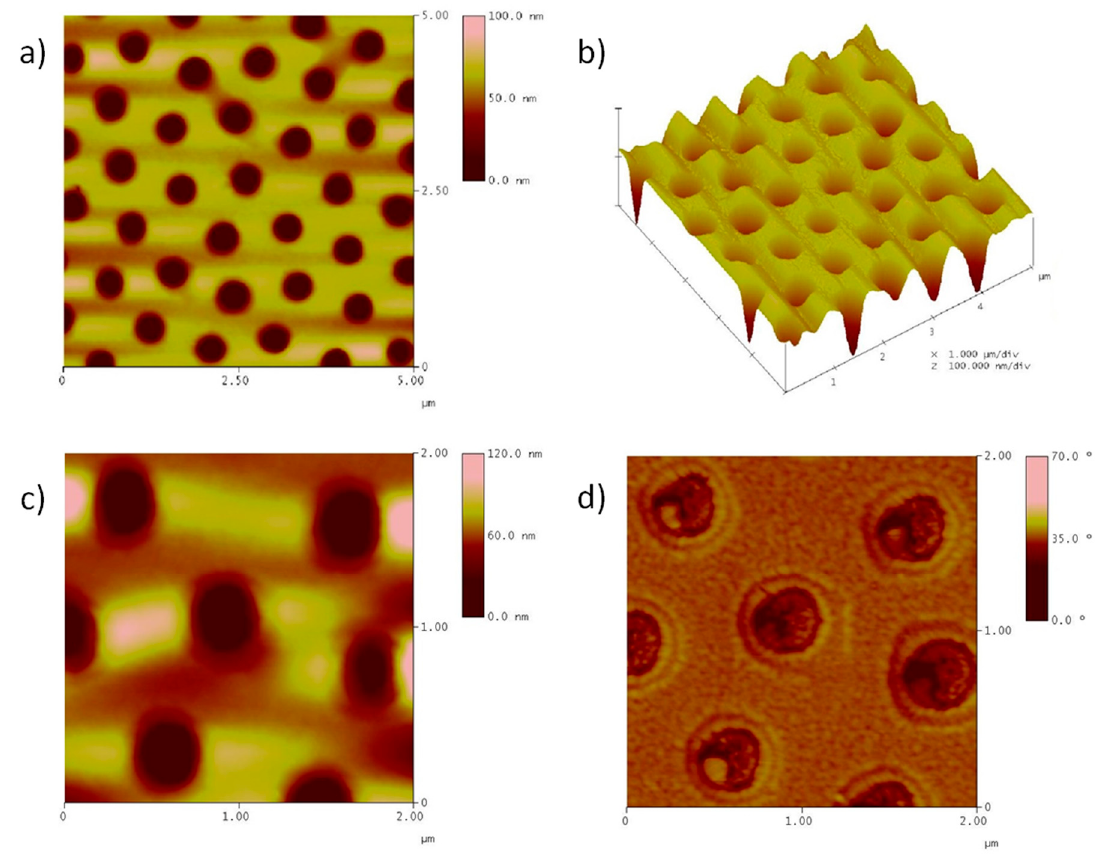
Figure 5. Atomic Force Microscopy (AFM) topography ( a – c ) and phase ( d ) images on dodecagonal plasmonic crystals implanted on PMP film. The side of the square image in ( a , b ) is 5 µm; in ( c , d ), it is 2 µm. The colored bar on the right in ( a , c , d ) explains the color scale in the images.